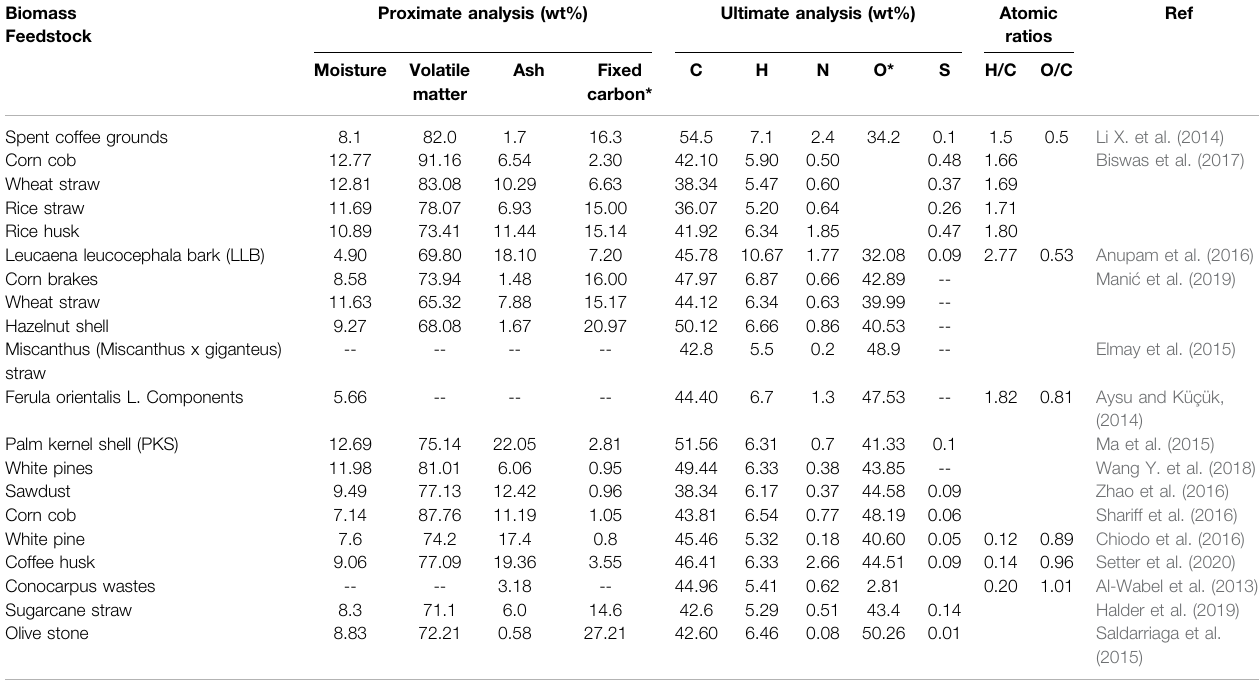
Proximate analysis (wt%)